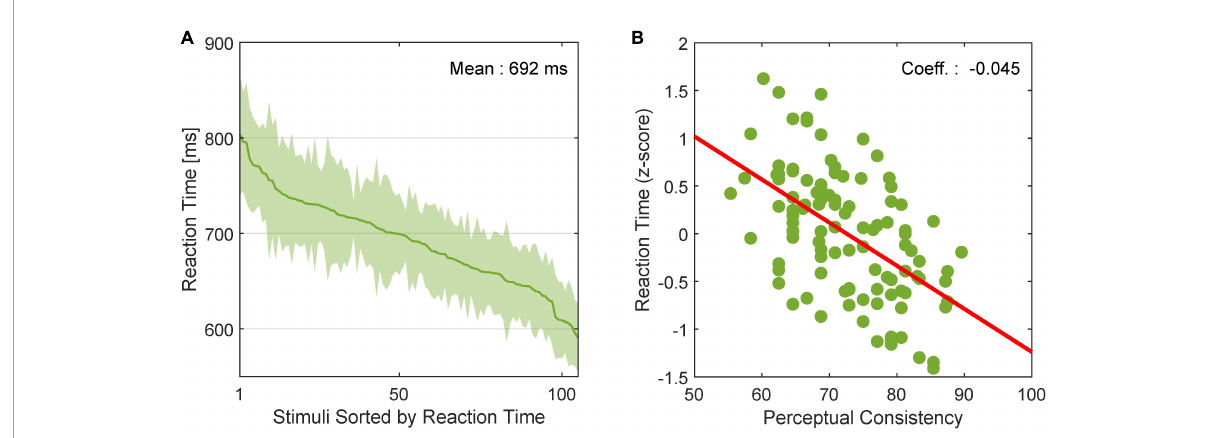
FIGURE7 Reaction time of human FG perception. (A) RT for FG perception in rank order. The solid line and shade indicate the mean and SE, respectively, across participants. (B) Relationship between PC and RT in z score. Dots represent individual stimuli. The red line indicates the linear regression